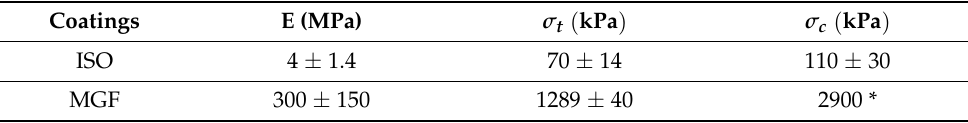
Table 1. Mechanical properties of the tested coatings.